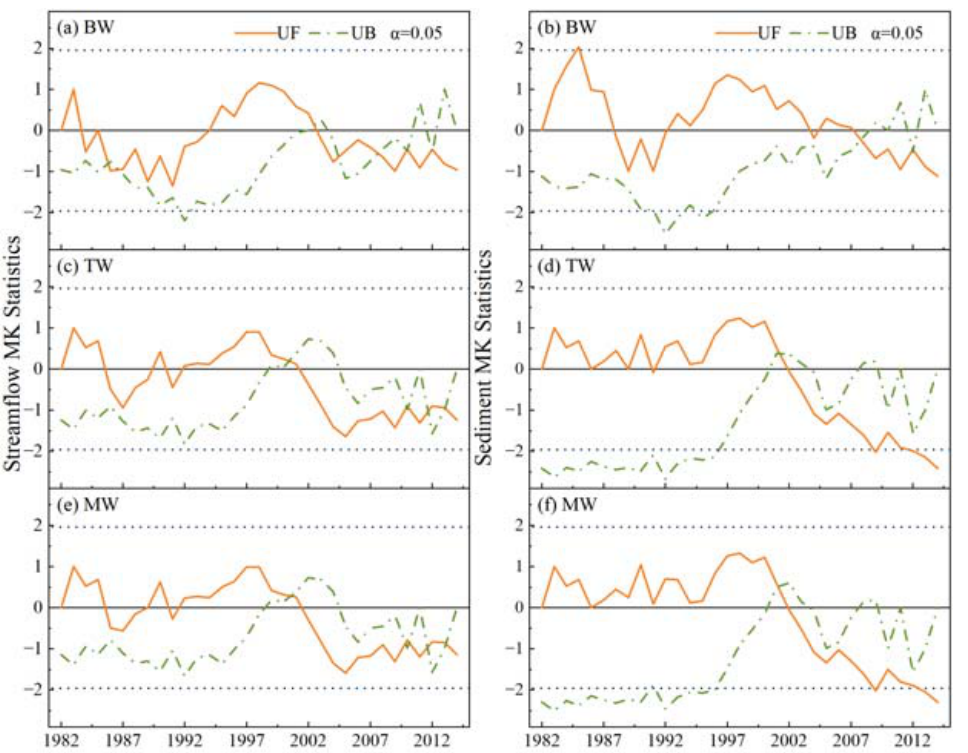
Figure 7. MK trend test of annual streamflow and sediment yields for BW ( a , b ), TW ( c , d ), and MW ( e , f ).